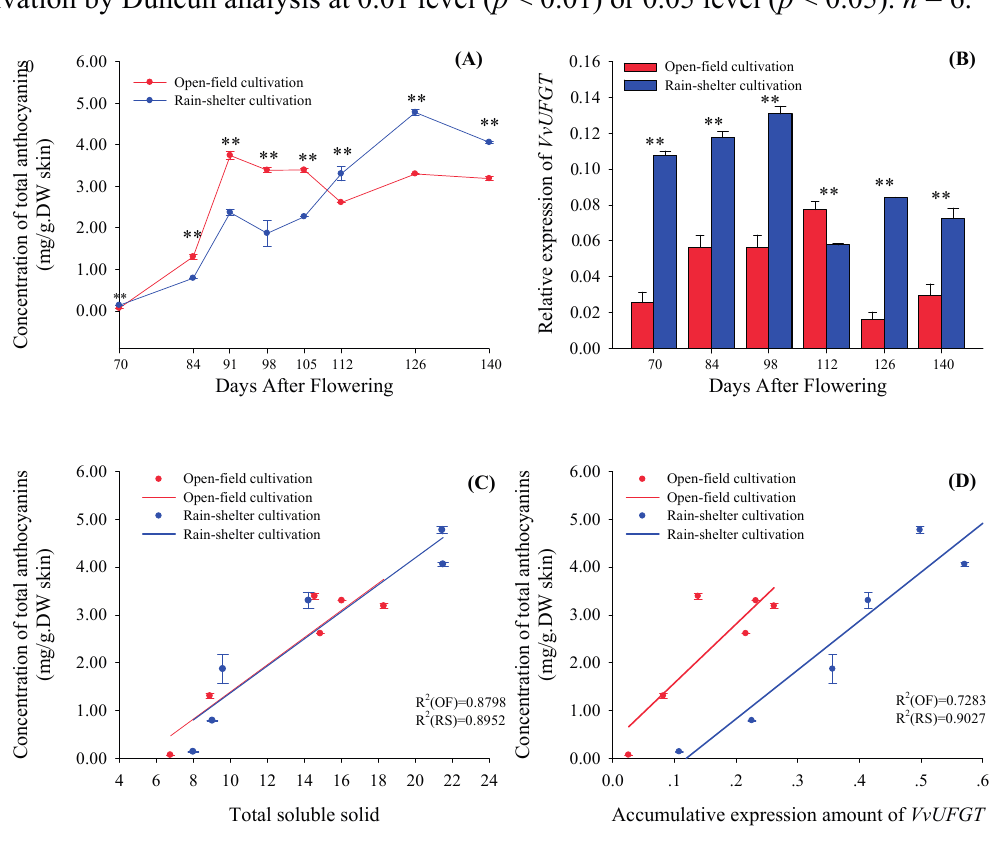
Figure 3. The variation of concentration of total anthocyanins ( A ) and relative expression of VvUFGT ( B ) in berry skins of vines grown under open-field cultivation (OF) and rain-shelter cultivation (RS). The linear correlations between evolution of total anthocyanins and total soluble solids ( C ), as well as between total anthocyanins and VvUFGT expression ( D ). Data are mean ± standard deviation. The symbol “**” or “*” above each set of columns represents that there are significant difference between rain-shelter cultivation and